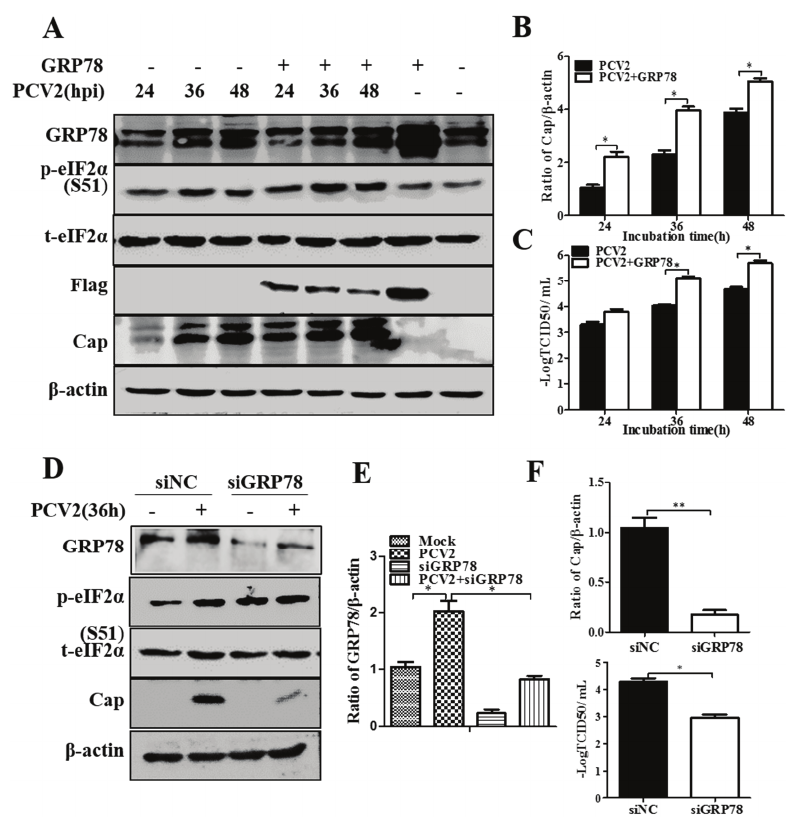
Figure 4. Effects of GRP78 over-expression or knockdown on porcine circovirus 2 replication. PK-15 cells were first transfected with the vector expressing GRP78 or with GRP78-specific siRNA (siGRP78). Control vector pcDNA or scrambled RNA (siNC) was used as control. After 24 h of transfection, the cells were infected with PCV2 or mock-infected for indicated time points. Whole cell lysates were subjected to Western blotting for GRP78, phosphorylated eIF2 α (p-eIF2 α ), total eIF2 α (t-eIF2 α ), Flag tag, and viral capsid protein (Cap). ( A ) Representative blot showing the effects of GRP78 over-expression on target proteins; ( B ) Ratio of Cap to β -actin normalized to mock infection set at 1.0; ( C ) Virus titers expressed as log TCID 50 /mL; ( D ) Representative blot showing the effects of GRP78 silencing on target proteins; ( E ) Ratio of GRP78 to β -actin; ( F ) Ratio of Cap to β -actin normalized to control cells set at 1.0 (top panel) and virus titers expressed as log TCID 50 /mL (bottom panel).